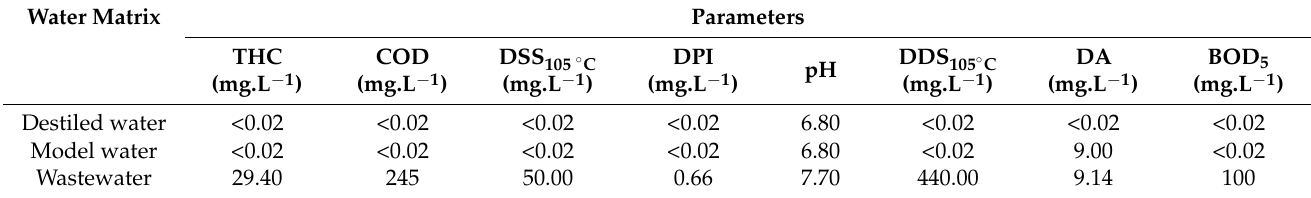
Table 1. Parameters of used